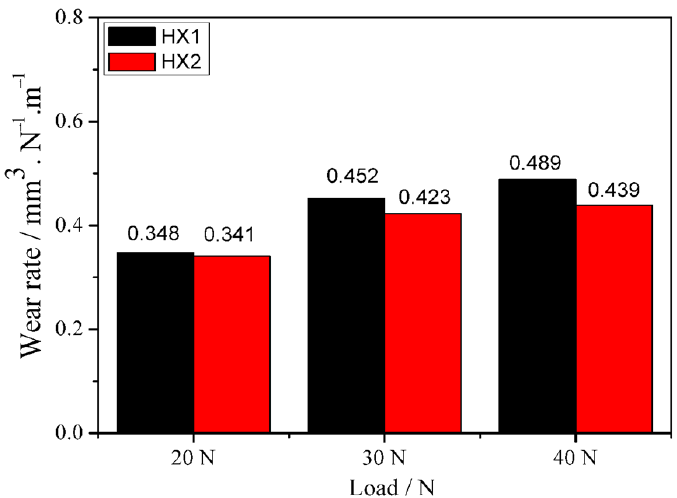
Figure 7. Wear rate of the HX1 and HX2 coatings under different applied loads.